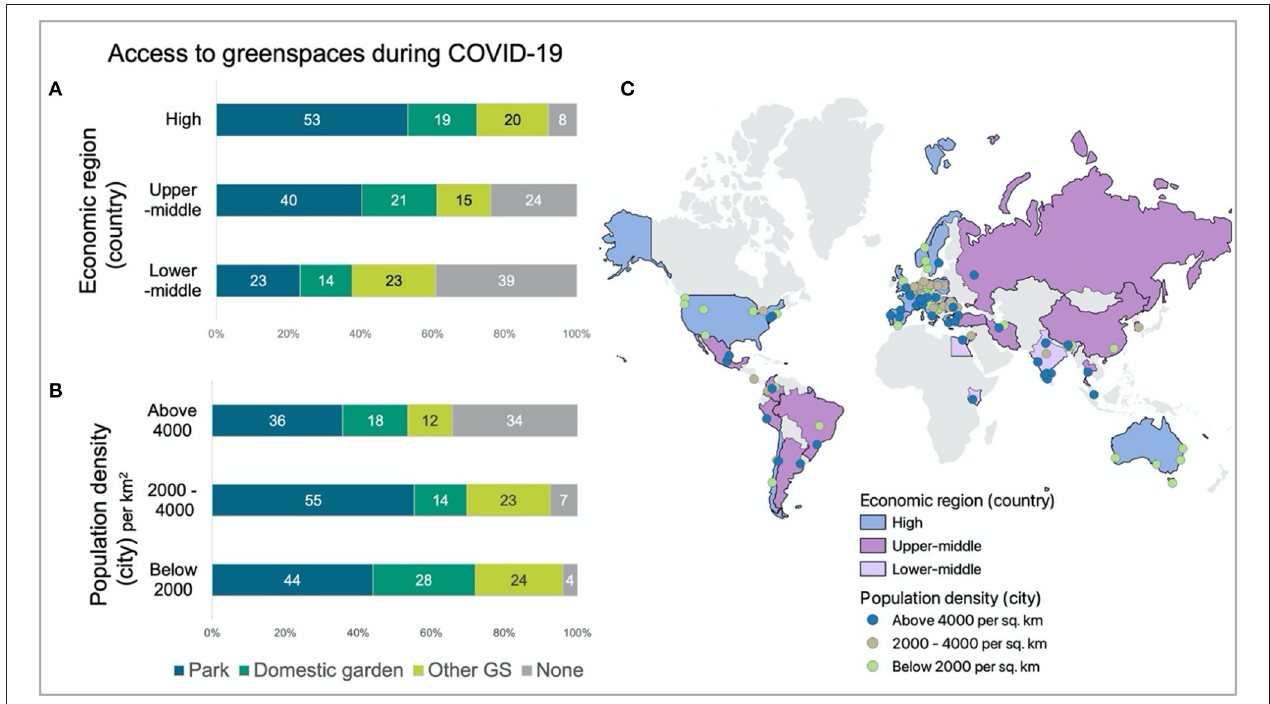
FIGURE 3 | (A,B) Association between respondents’ access to greenspaces during COVID-19 with regard to economic region ( χ 2 = 52.5 at p < 0.001) and population density ( χ 2 = 67.9 at p < 0.001), respectively. (C) Distribution of survey respondents ( N = 428) with respect to economic region (as of World Bank, 2020) and population density of urban area (UN DESA—United Nations Department of Economic and Social Affairs (Population Division),